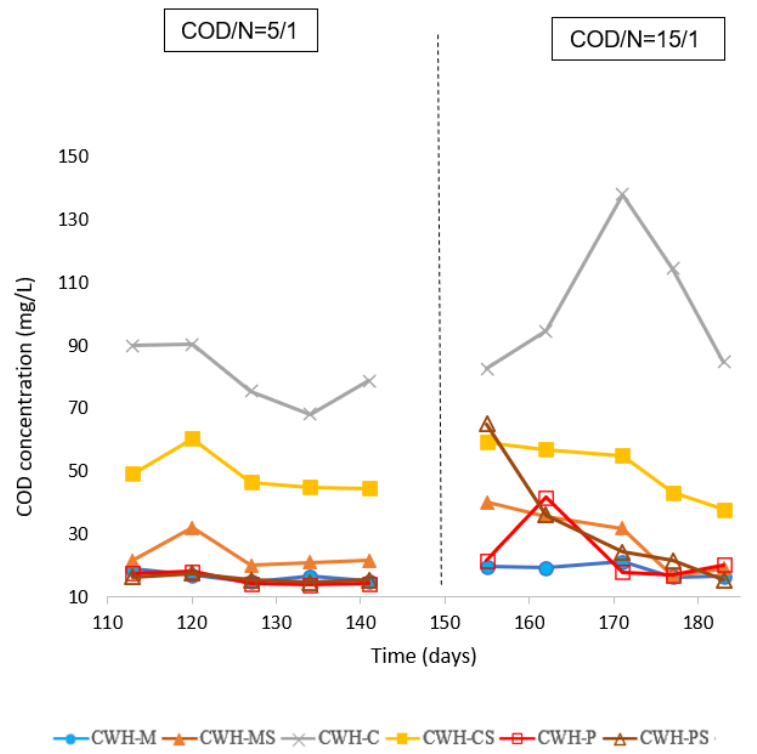
Figure A2. COD concentration in all the studied CWH effluents over the experimental period.